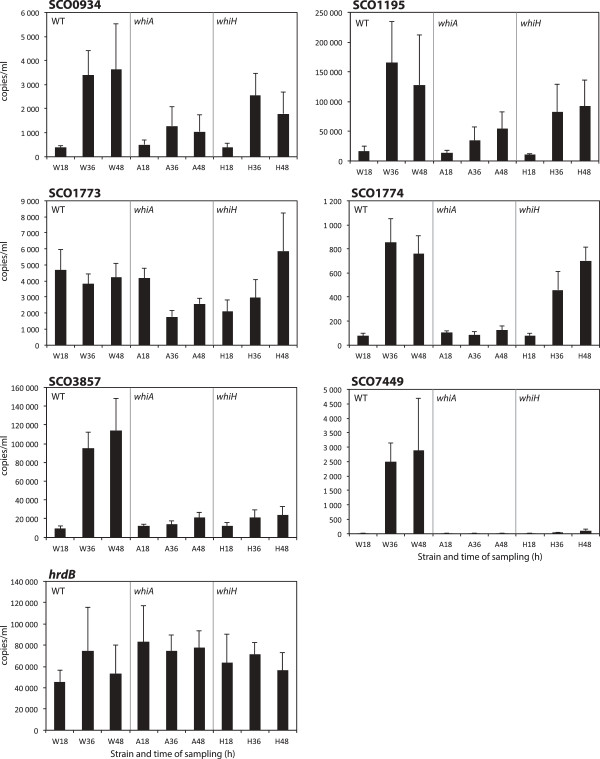
Quantitative real-time RT-PCR assays of selected genes. Specific primer pairs were used to amplify SCO0934, SCO1195, SCO1773, SCO1774, SCO3857, SCO7449, and hrdB from cDNA prepared from cultures of the parent M145 (marked with W), J2401 (whiA mutant, marked with A) and J2408 (whiH mutant, marked with H) after 18 h, 36 h and 48 h of growth. The assay for each gene was calibrated to the absolute concentration of template per ml reaction volume. Error bars show standard deviations from a total of six assays.